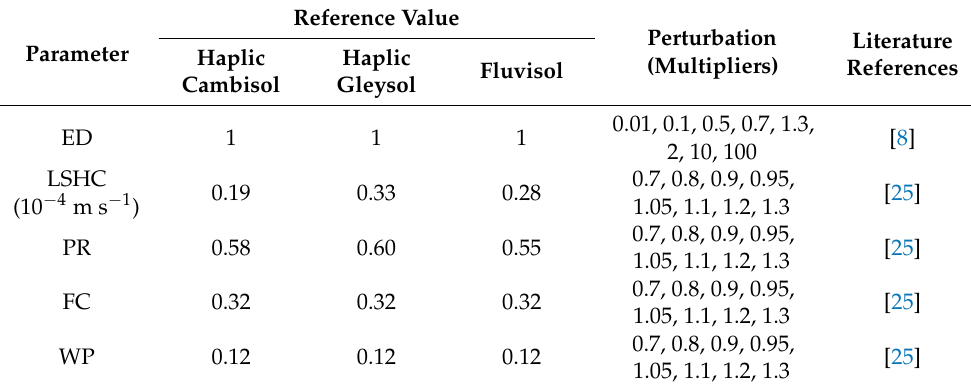
Table 2. Parameters, respective reference values, perturbations, and literature references for reference